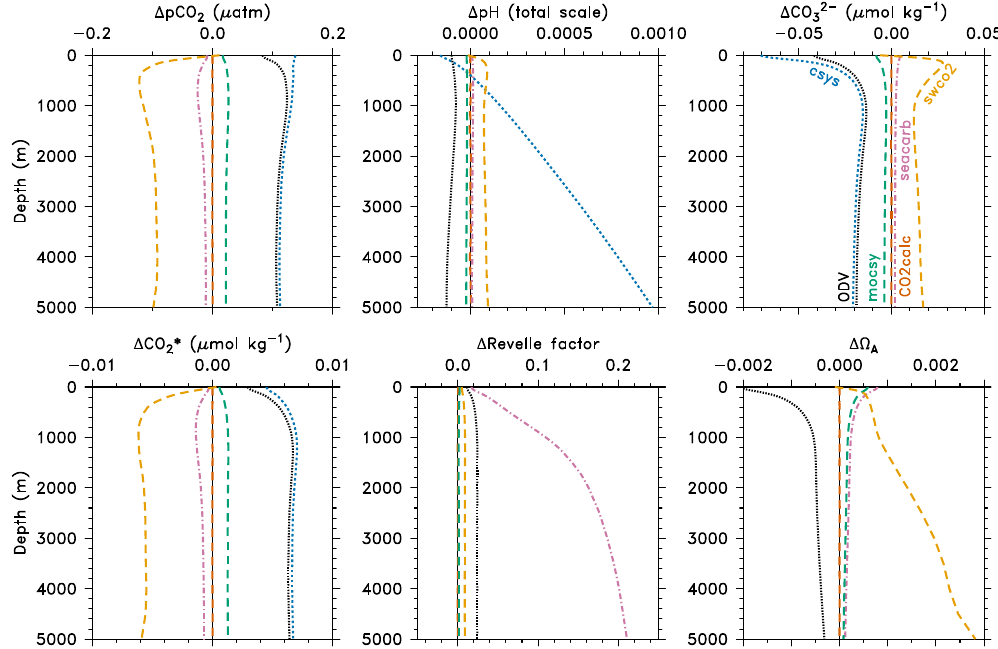
Figure 3. Global-mean vertical profiles of variables computed from the same gridded data products as in Fig. 2. For each software package, corresponding results from the reference (CO2SYS-MATLAB) have been subtracted. The csys curves are adjusted as in Fig. 2. In all comparisons, the csys results are computed with the option ocdflag = 1; its discrepancies would be larger with ocdflag =